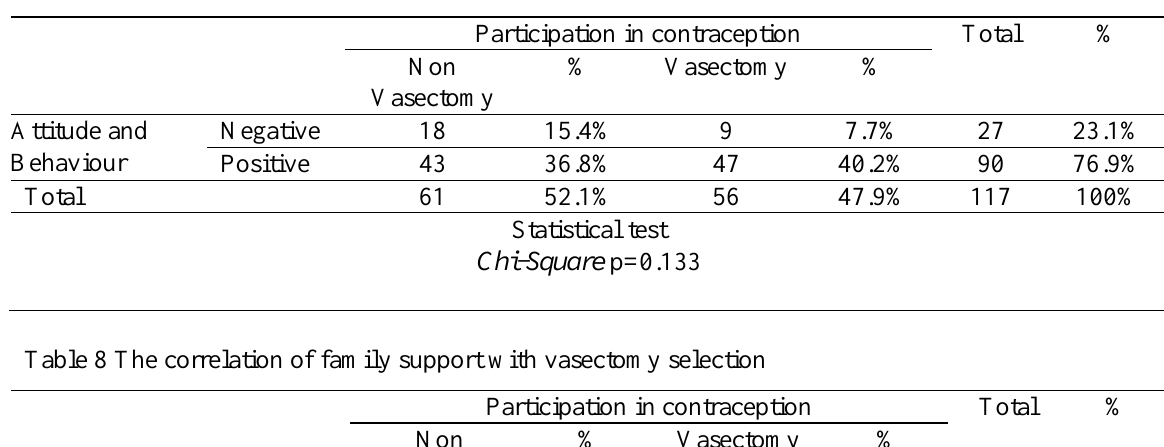
Table 7 The correlation of attitude and behaviour of health workers with vasectomy selection